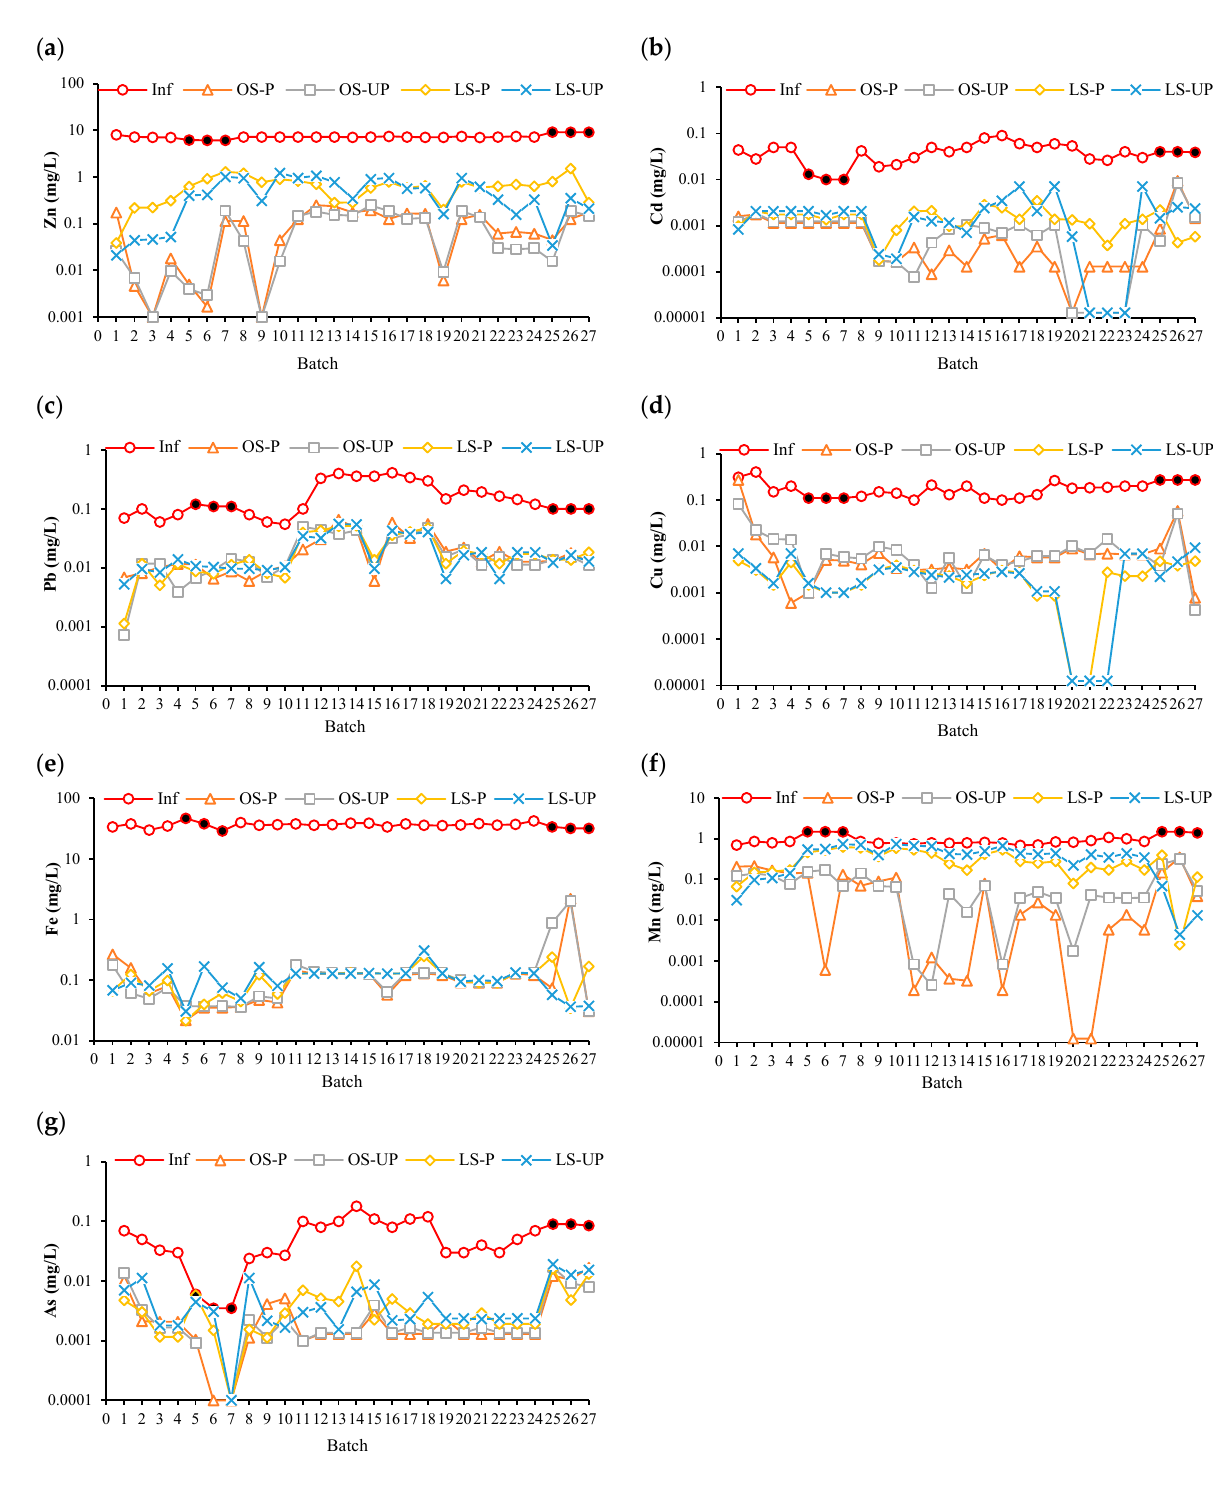
Figure 3. Heavy metal concentrations in influent and effluent for oyster shell (OS)/limestone (LS)- based planted (P)/unplanted (UP) CWs treating real and synthetic AMD in sequencing batch mode: Zn ( a ), Cd ( b ), Pb ( c ), Cu ( d ), Fe ( e ), Mn ( f ), and As ( g Table 3. Mass removal efficiency (%) of heavy metals from simulated and real AMD using CWs filled with oyster shells (OS) or limestone (LS), unplanted (UP) or planted (P) with cattails (avg±SD). Simulated AMD ( n = 21) Real AMD ( n = 6) OS-UP